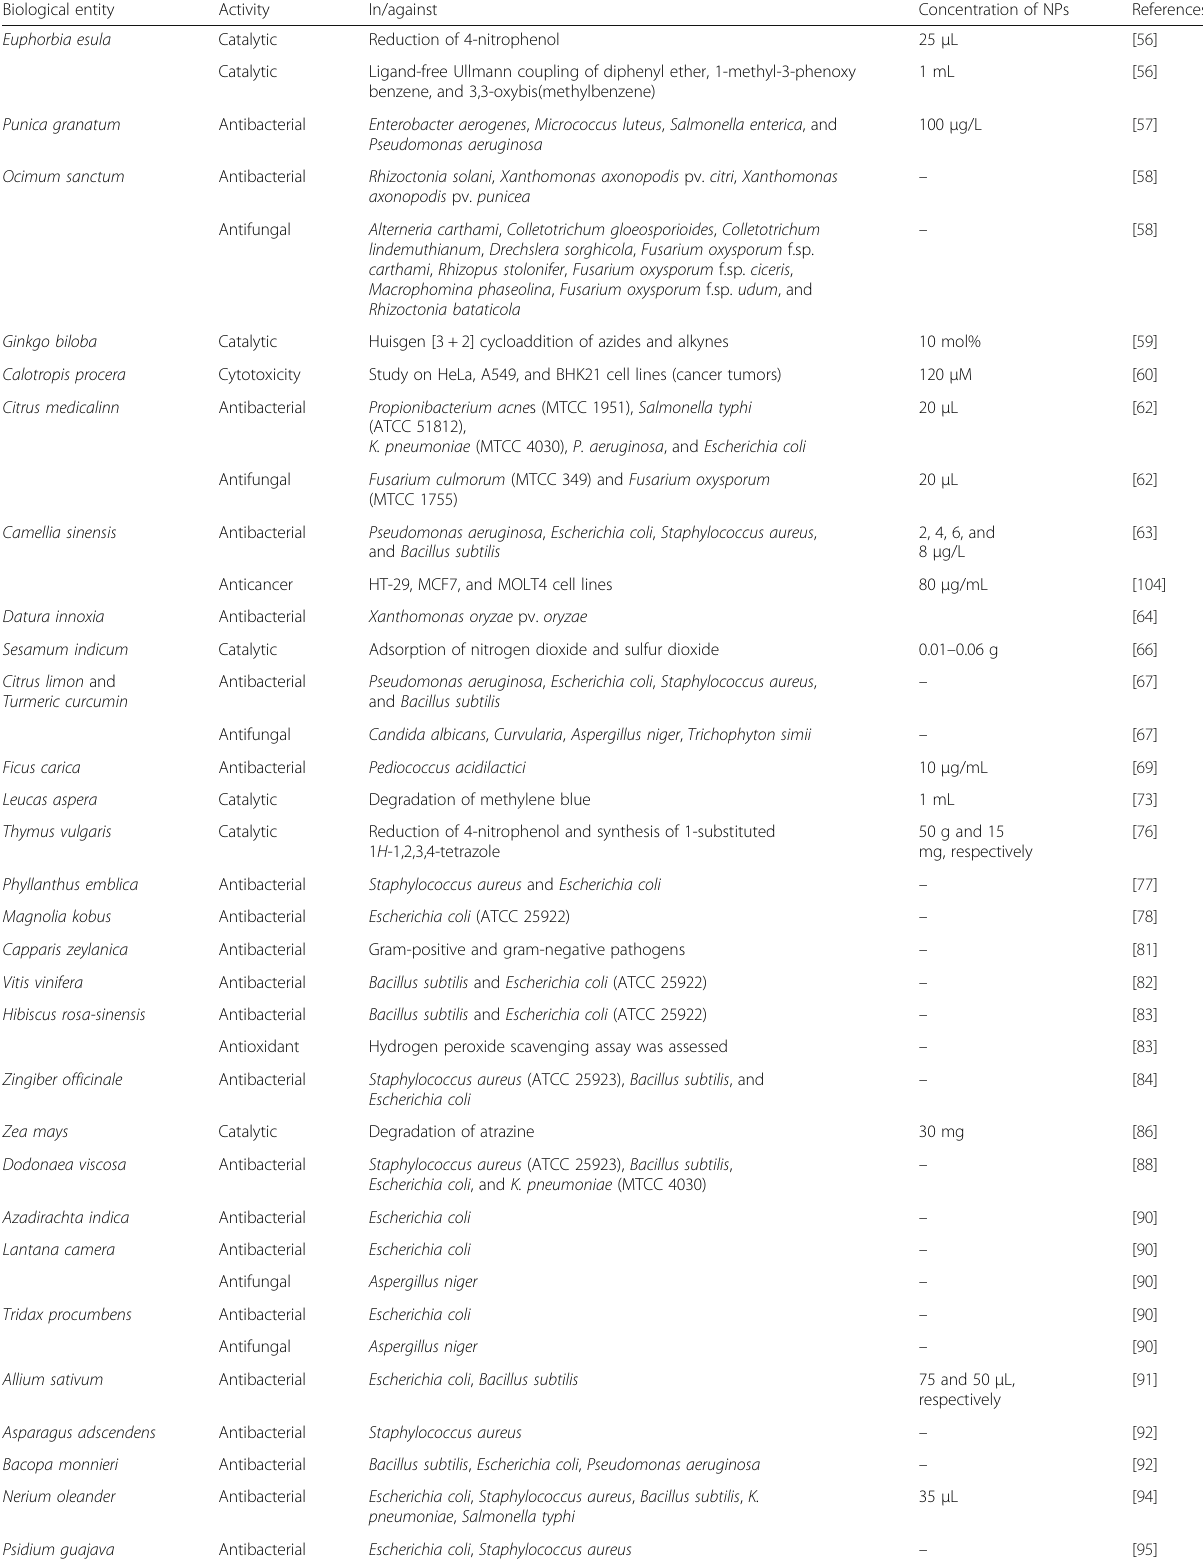
Table 4 Catalytic, antibacterial, cytotoxicity or anticancer, antioxidant, and antifungal activities of copper